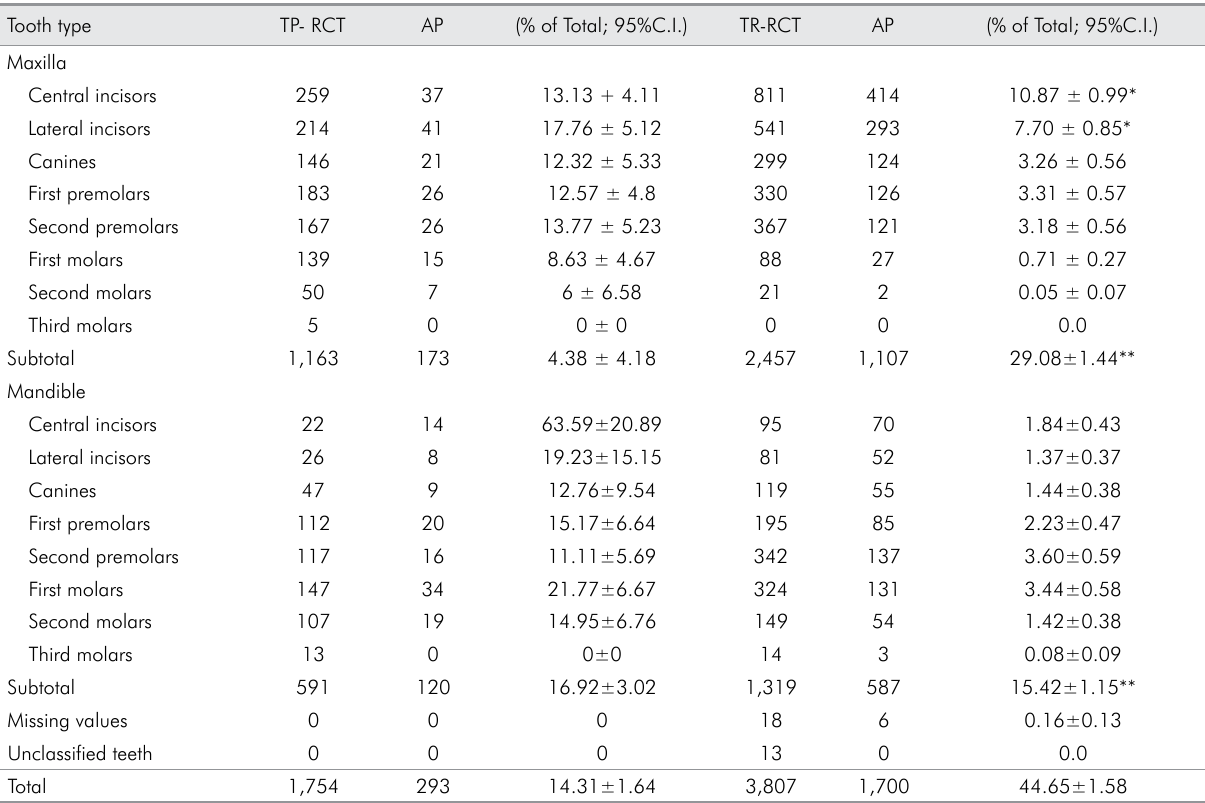
Table 4. Prevalence of apical radiolucency (AP) according the tooth type among teeth with previous RCT (TP-RCT) and among teeth referred for RCT (TR-RCT) (percentage and